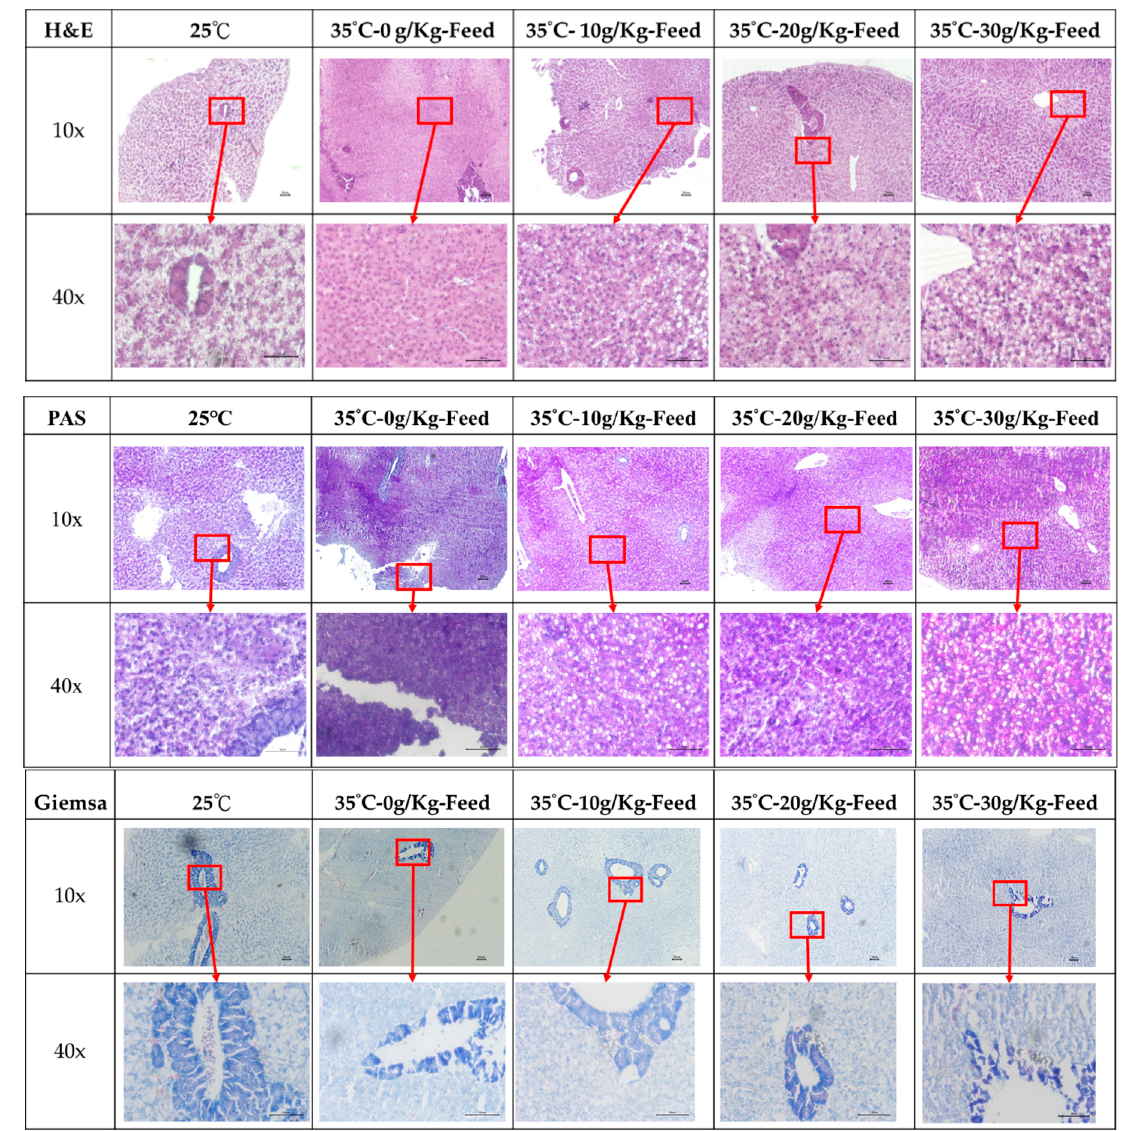
Figure 8. Histological observation of the liver stained by the H&E, PAS and Giemsa stain. The black bar was presented as 50 μ m.